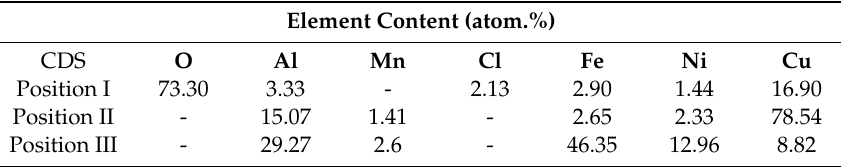
Table 3. The composition of CDS immersed in 3.5% NaCl solution for 3 h [17].